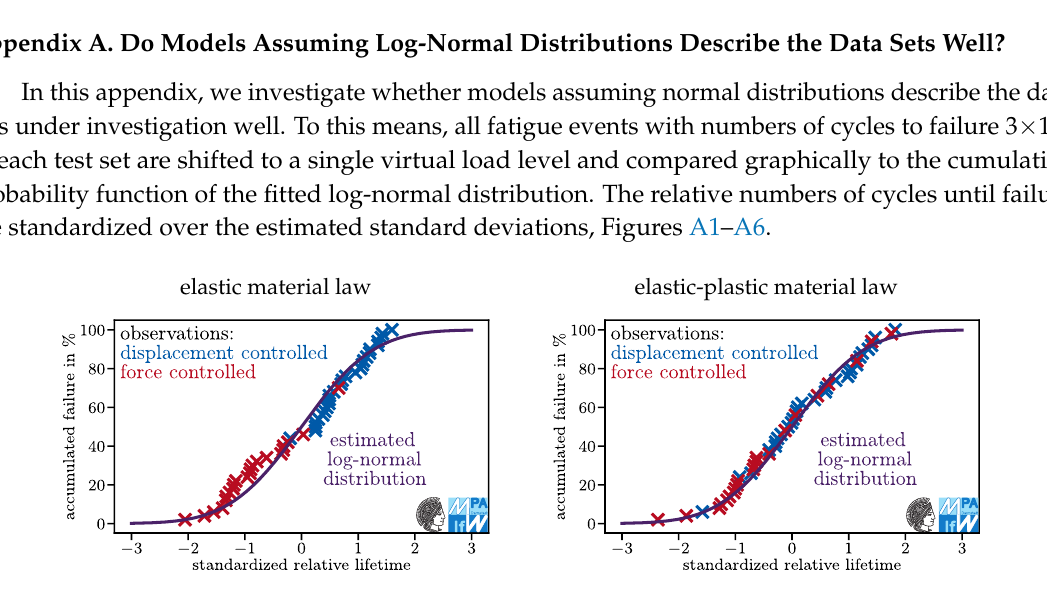
Figure A1. Estimated and observed accumulated failure rates for 50CrMo4 specimens in laboratory air; 919MPa ultimate tensile strength; K t =